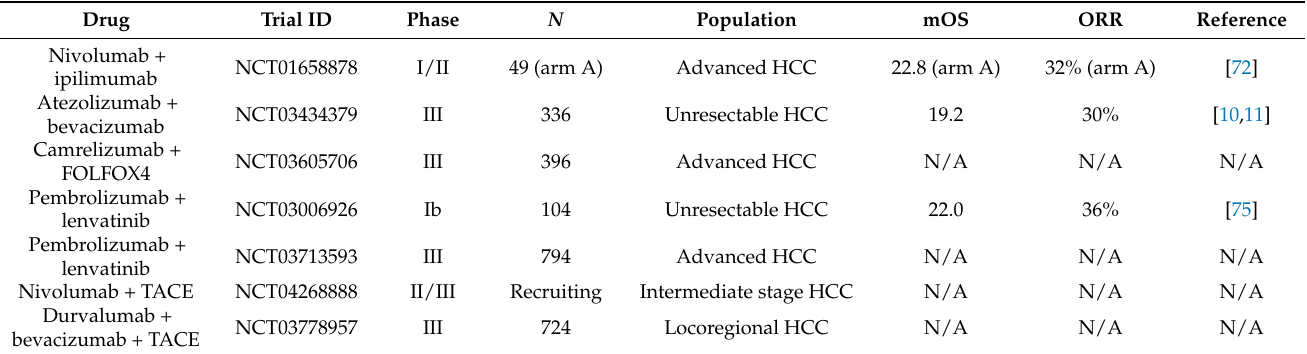
Table 2. Selected clinical trials of combinations of ICIs and other therapies for